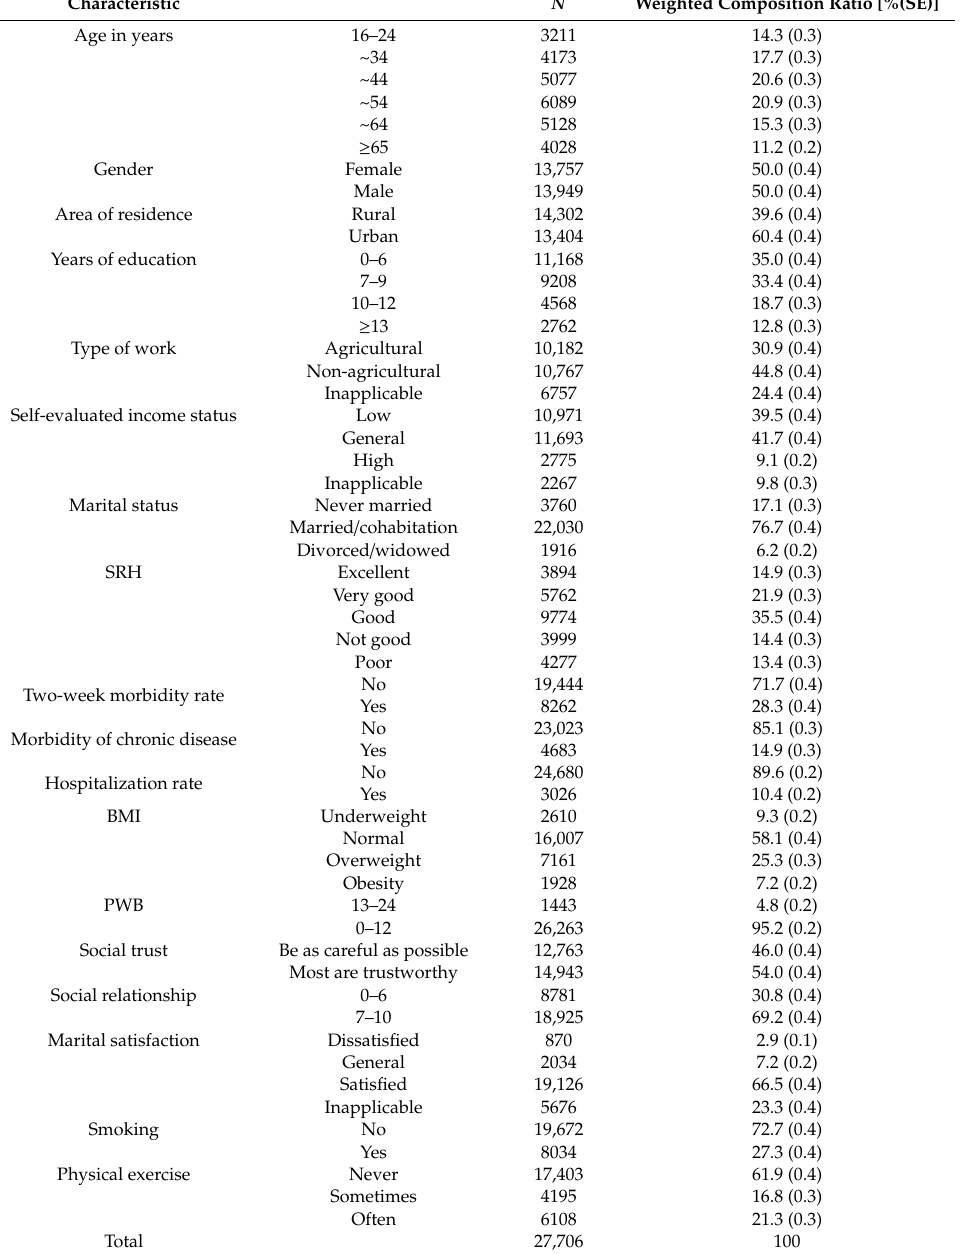
Table 1. Characteristics of the study